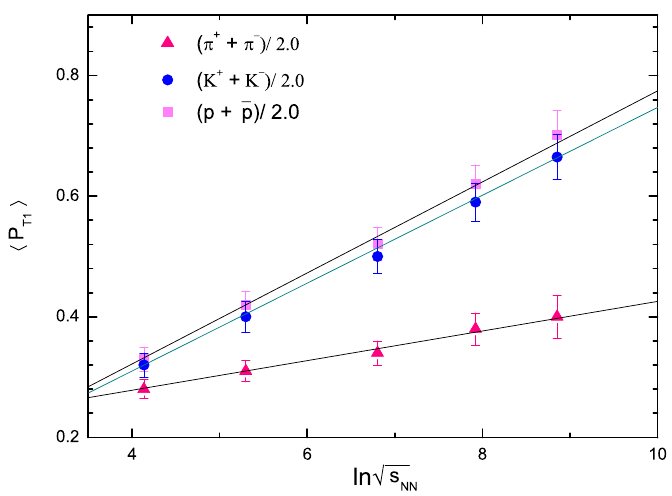
√ s NN . The symbols